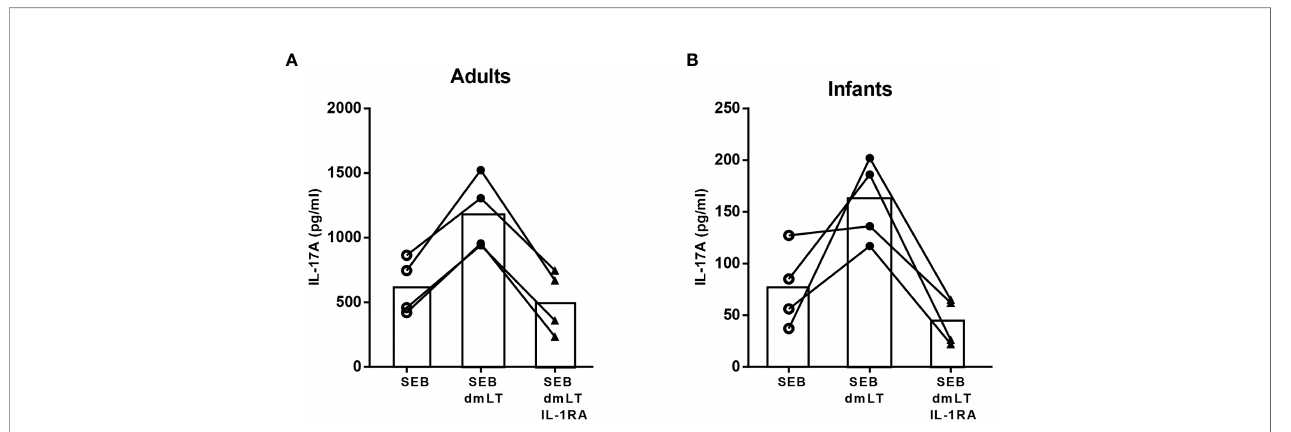
FIGURE 3 | Role of IL-1 signaling in dmLT-induced promotion of IL-17A responses. IL-17A concentrations in cultures with PBMCs from (A) adults (n = 4) and (B) infants (n = 4) stimulated with SEB alone or SEB + 10 µg/mL dmLT with or without addition of IL-1 receptor antagonist (IL-1RA). Each symbol and line represents data from one